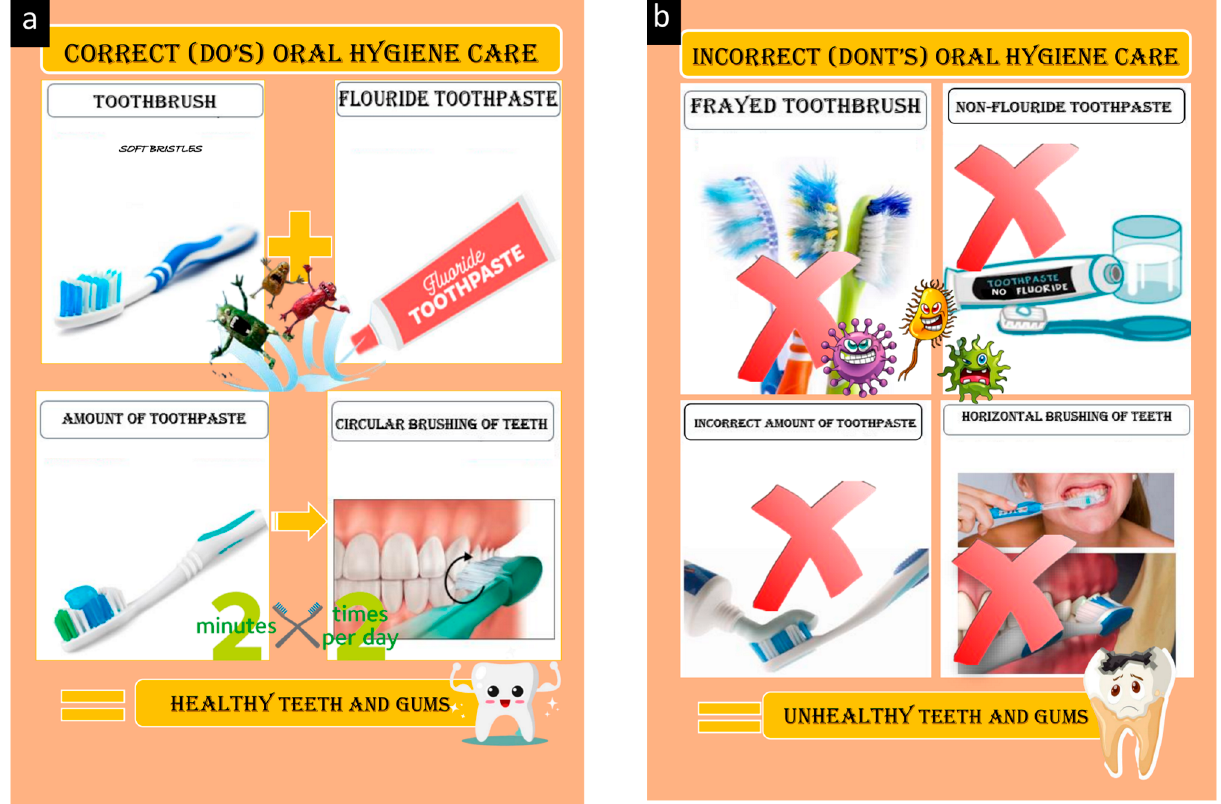
Figure 1. Picture illustrations; ( a ) correct (do’s) oral hygiene care; ( b ) incorrect (don’ts) oral hygiene care.